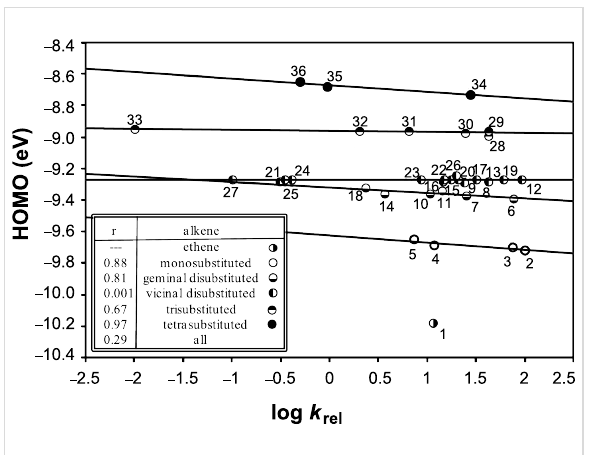
Figure 3: Plot of log k rel values for PhSeCl addition to alkenes versus their corresponding HOMOs, analogous to the plot in Figure 2. Point numbers correspond to entries in Table 1.